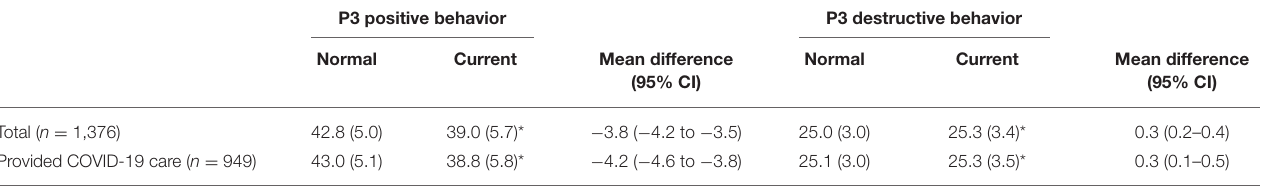
TABLE 2 | Comparing palliative behavior scale scores for positive stress reducing activities and destructive stress reducing activities.